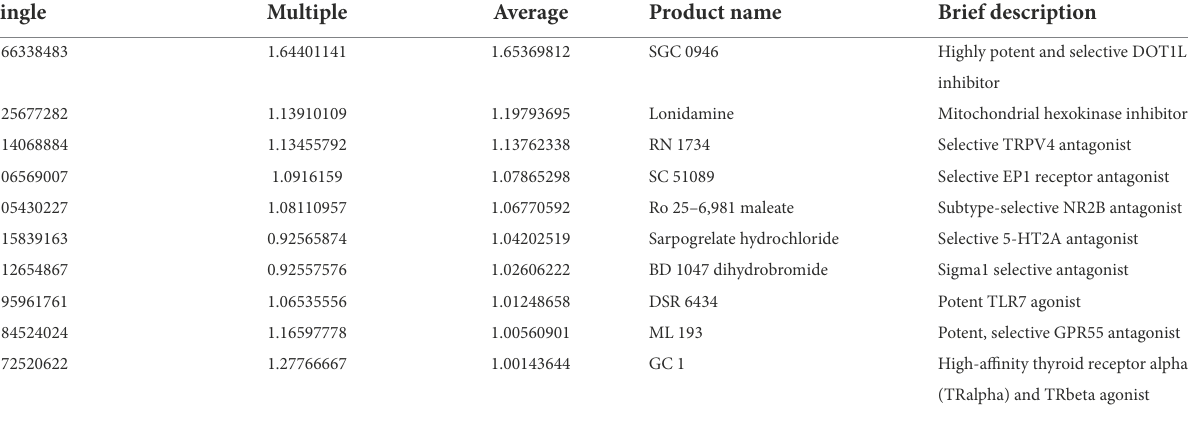
TABLE 2 Top 10 positive responses to small molecules of the Tocriscreen 2.0 library * .